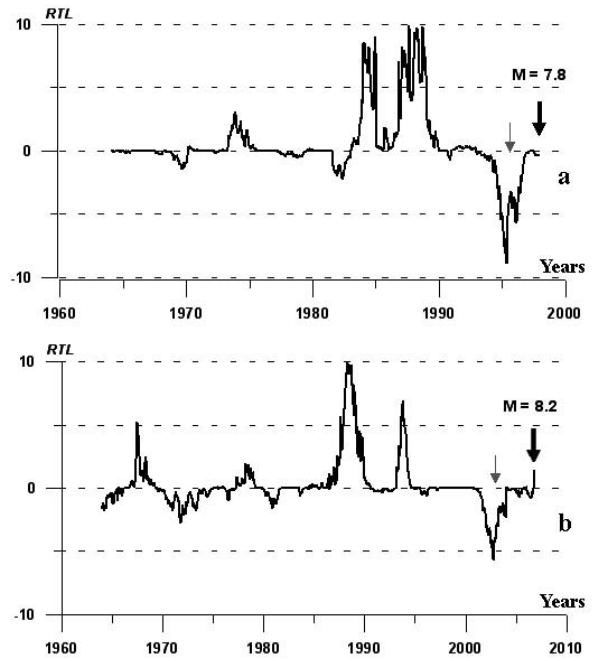
Fig. 3. Temporal variations of the RTL parameter (a) at epicenter of the Kronotskoe and (b) at epicenter of the Simushirskoe earthquakes. The thick arrows mark the moments of these events. The thin arrows indicate the times when the reports were sent to the National Earthquake Prediction Council of the Russian Ministry Emergency Situations.